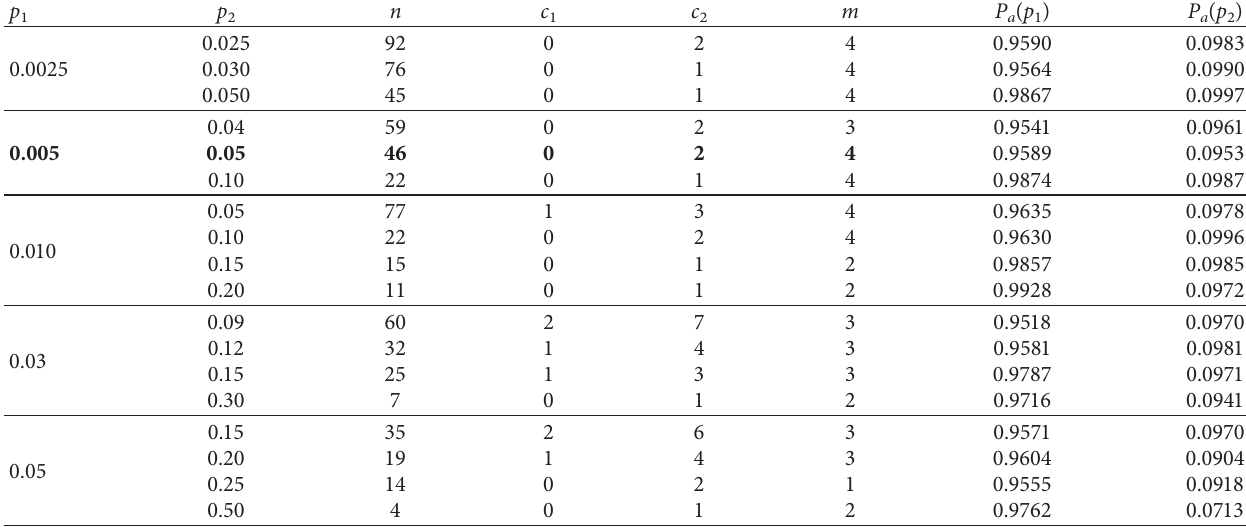
Table 1: Plan parameters of modified MDS sampling plan for binomial distribution with β � 0.10.